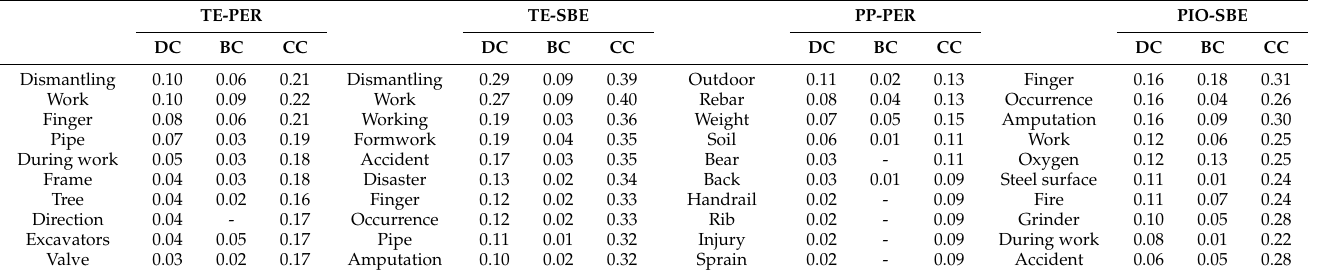
Table 2. Centrality analysis result of semantic network analysis on accident